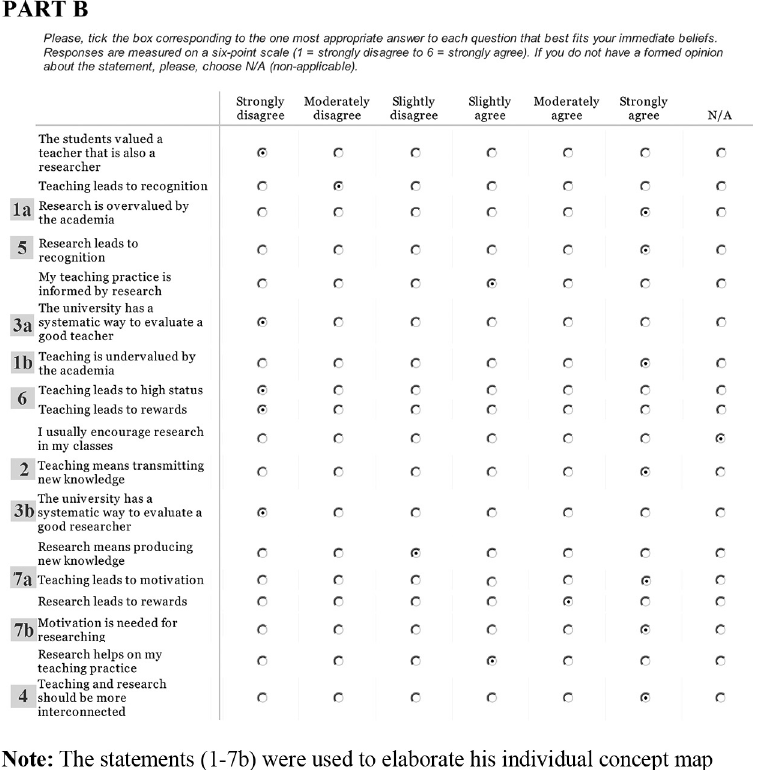
Figure 2. One academic ’